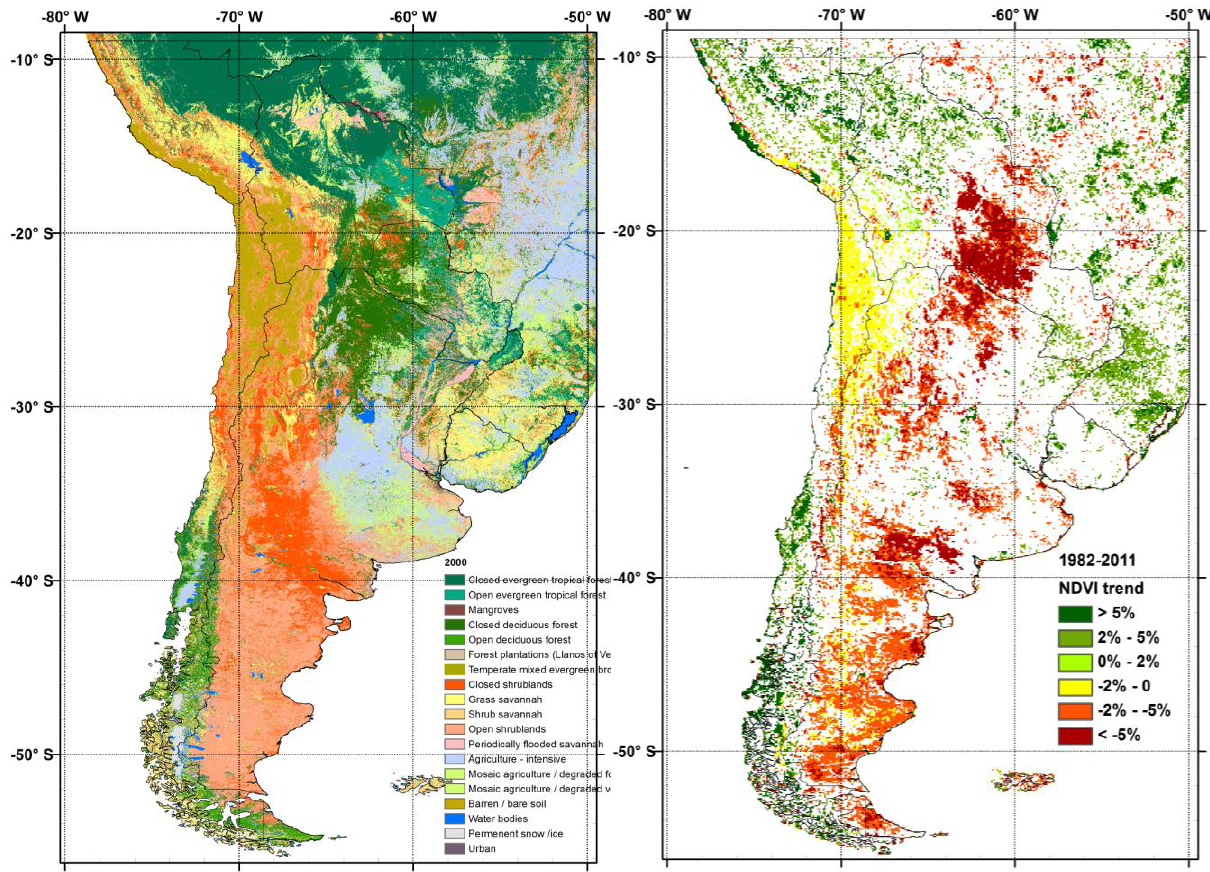
Figure 8. Significant positive and negative trends ( p ≤ 0.05) in annual mean NDVI based on 30 years of continuous NDVI time series data (1982–2011) are shown in the right side figure. Land cover is provided as a